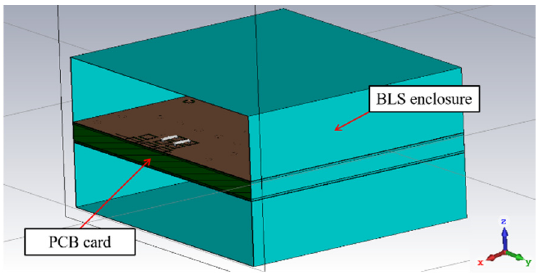
Figure 11. Sectional view of the PCB card shielded with a BLS type enclosure 3D model. Table 3. Different BLS enclosure shielding